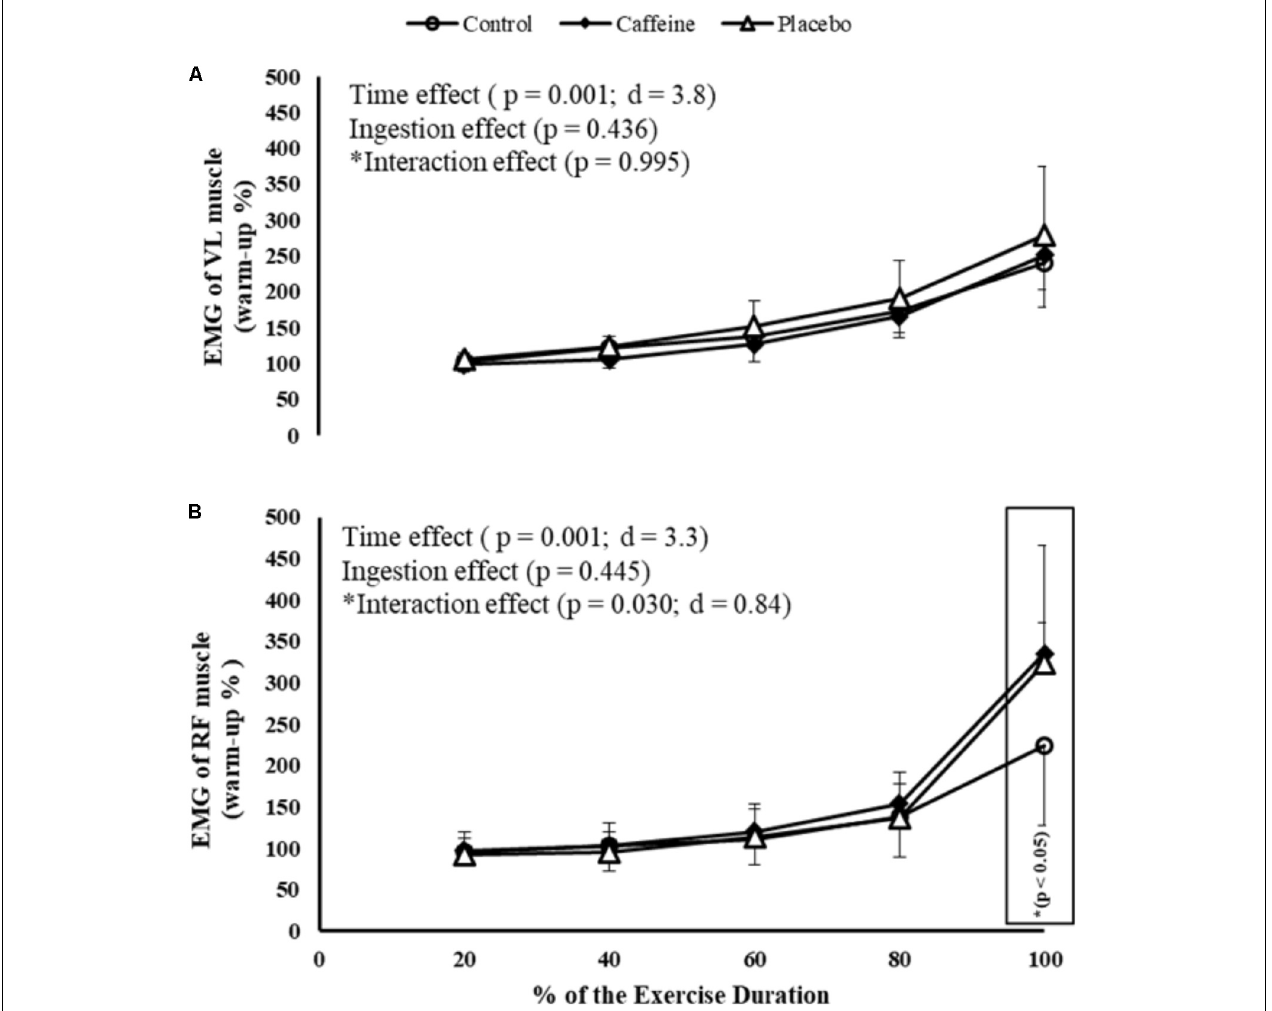
FIGURE 1 | EMG of vastus lateralis (VL; A ) and rectus femoris (RF; B ) muscles during maximal incremental test (MIT) in control, caffeine and placebo (perceived as caffeine). Main effects of time and ingestion and time by ingestion interaction effects were reported in the figure. Values are mean ( ±